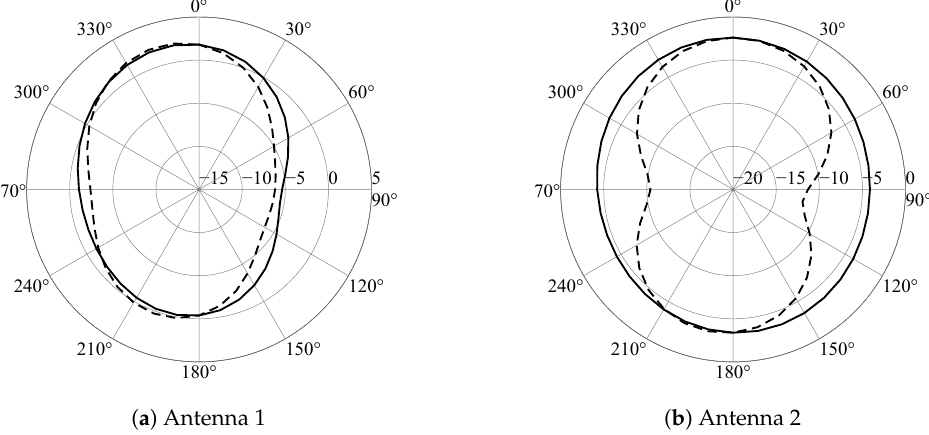
Figure 10. Realized gain of the antennas with φ = 0 ◦ (solid line) and φ = 90 ◦ (dashed line) for Configuration 2.